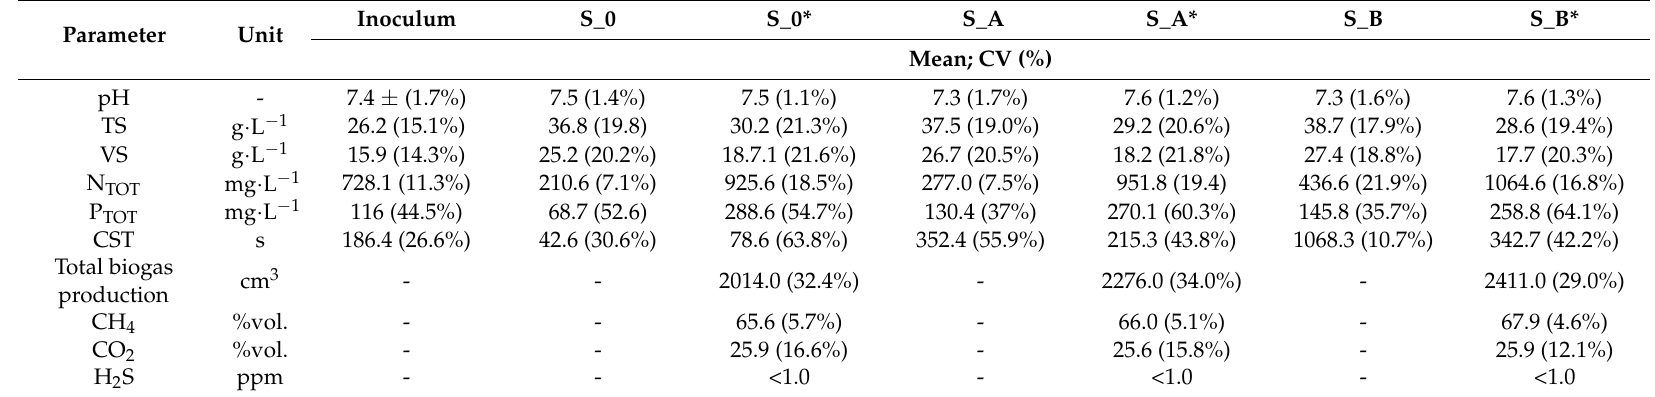
Table 5. The characteristics of the sludge sample before and after anaerobic digestion—technological